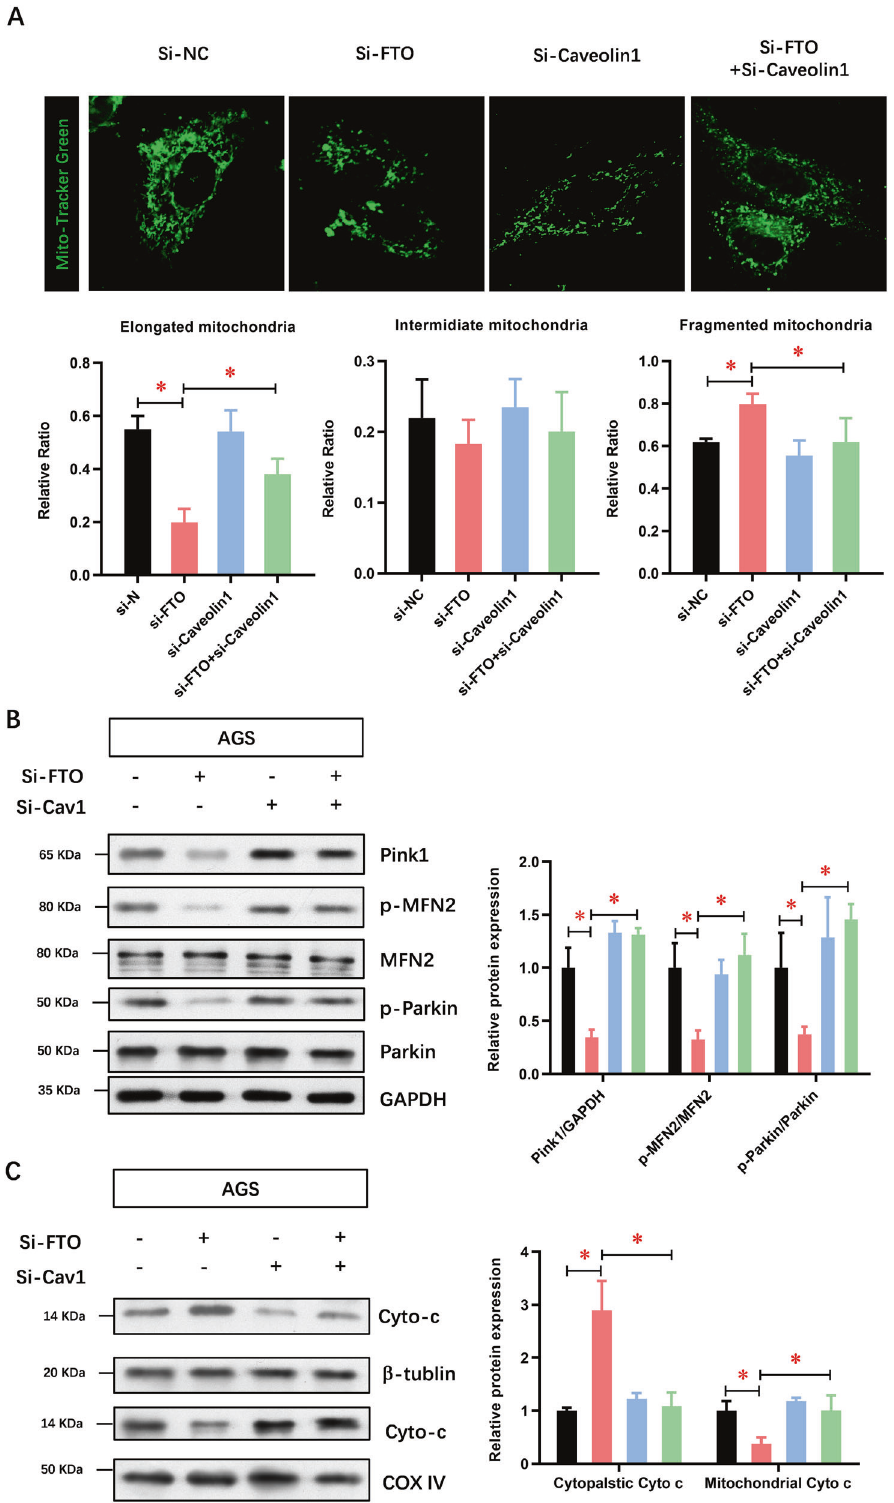
Fig. 7 FTO depletion induces mitochondrial fi ssion in GC cells via caveolin-1. A MTG staining and confocal microscopy were used to observe the mitochondrial fragmentation in AGS cells. B The regulatory molecules of mitochondrial fi ssion and fusion, including Pink1, Parkin1, and MFN2, were analyzed. C The regulatory molecule of mitochondrial pathway apoptosis, indicated by cytochrome c release from mitochondria, was analyzed. N = 3, * p < 0.05, ** p < 0.01 compared with the indicated group.